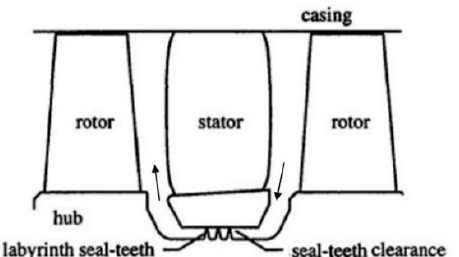
Figure 1. The seal cavity leakage in a compressor with shrouded stator.